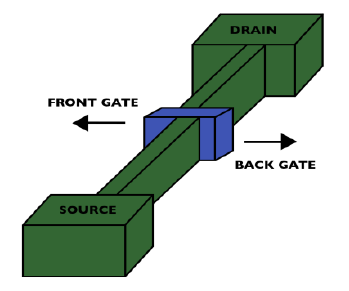
Figure 1. Structure of FinFET.